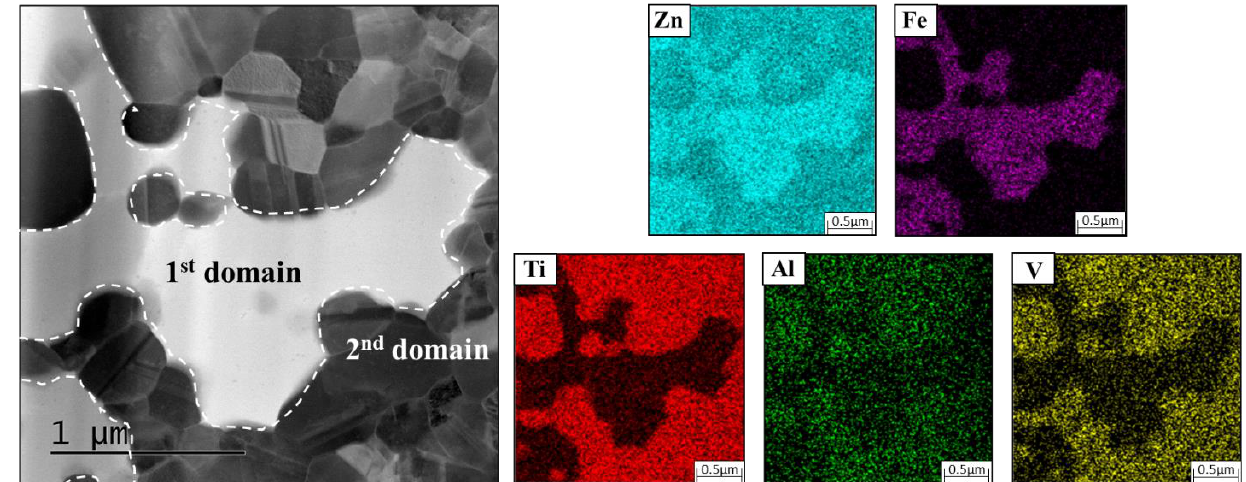
Figure 3. TEM-BF close-up view of the interface layer between the Ti-based lattice and Zn-2%Fe alloy along with chemical composition maps of elements in each domain obtained by STEM-EDS analysis. Table 2. Composition (at%) of grains of each domain located at the interface layer as obtained by STEM EDS.